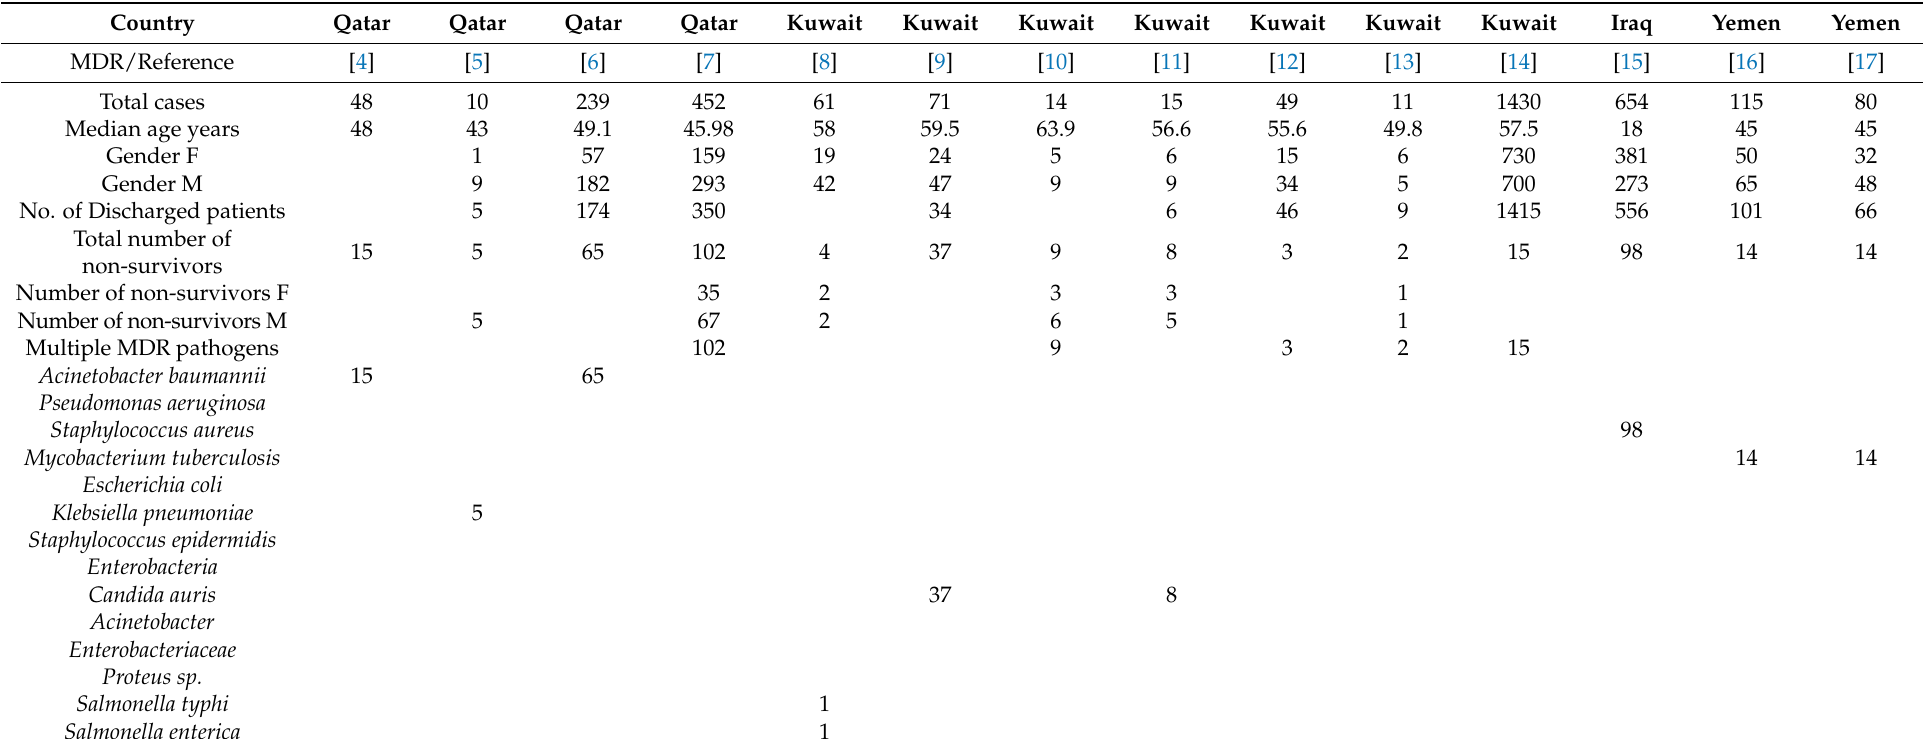
Table 3. Reports of mortality caused by MDR microbial infection from Qatar, Kuwait, Iraq and Yemen.